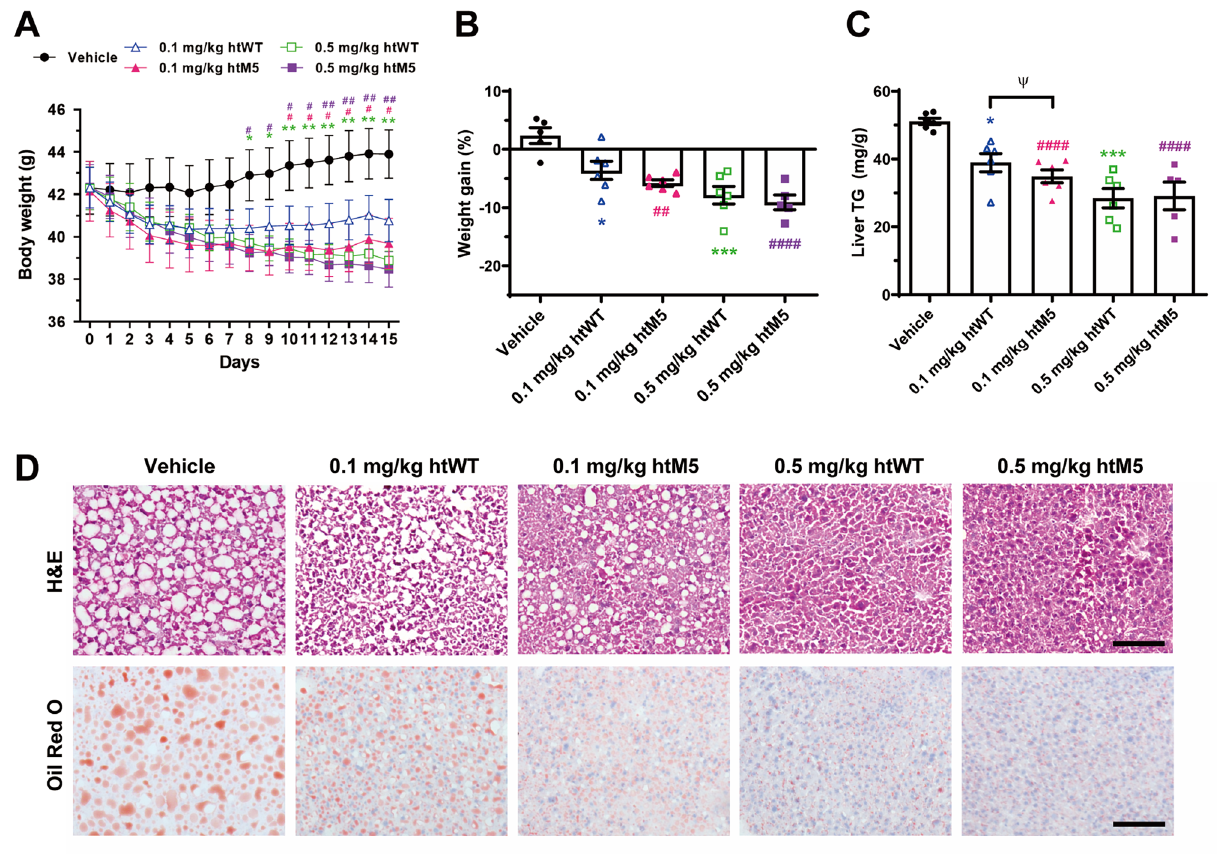
Figure 7. In vivo activity tests of htM5. HFD-fed mice were injected with the wild type htFGF21 (htWT) or htM5 intraperitoneally at doses of 0.1 or 0.5 mg/kg once daily for 14 days. ( A ) Changes in body weight throughout the injection. ( B ) Percent weight gains on the following day after the last injection. ( C ) Effects of the injection on liver TG contents. ( D ) H&E and Oil Red O staining of liver sections showing better improvement in htM5 than htWT for the vacuole and lipid accumulation. Data are represented as mean ± SEM, calculated using two-way ANOVA followed by Tukey’s multiple comparisons test, *, #, and Ψ p < 0.05, ** and ## p < 0.01, *** p < 0.001, #### p < 0.0001. n = 5–6 mice/group. *, **, and *** indicate vehicle-injected mice versus the htWT- injected mice. #, ##, and #### indicate vehicle-injected mice versus the htM5-injected mice. Ψ indicates the htWT-injected mice versus the htM5-injected mice. Scale bars: 100 μm (H&E), 50 μm (Oil Red